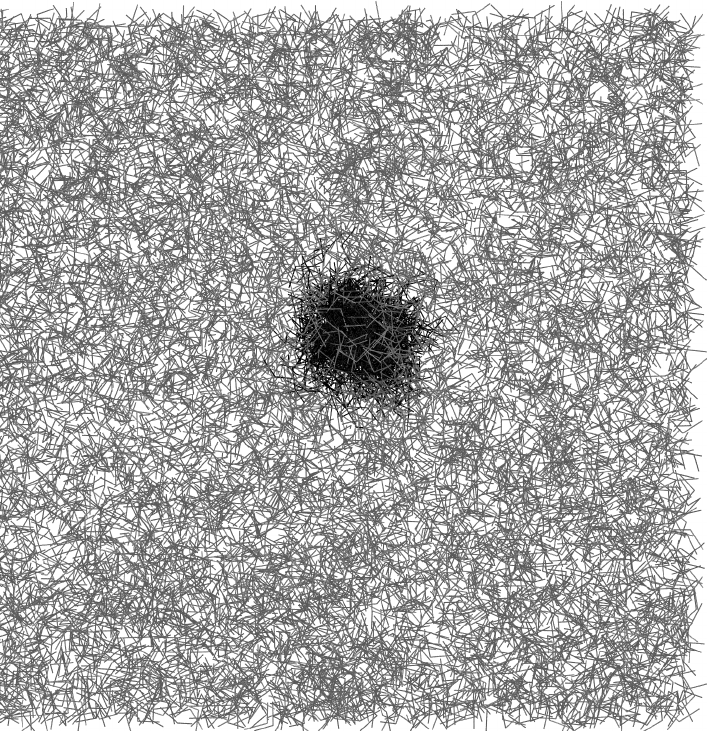
Figure 2. 10,000 snapshots for a single molecule from the dynamics are shown in gray and 1000 snap- shots in black after